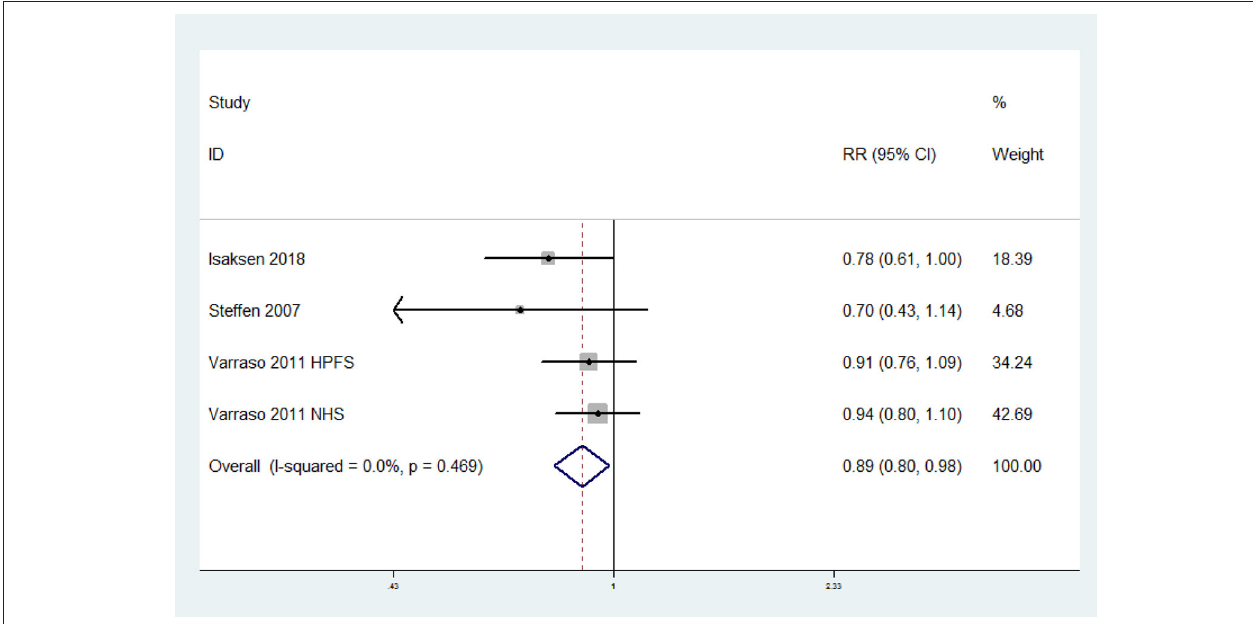
FIGURE 3 | Forest plot of meta-analysis: Overall multi-variable adjusted RR of VTE for the highest vs. lowest category of omega-3 fatty acids consumption.